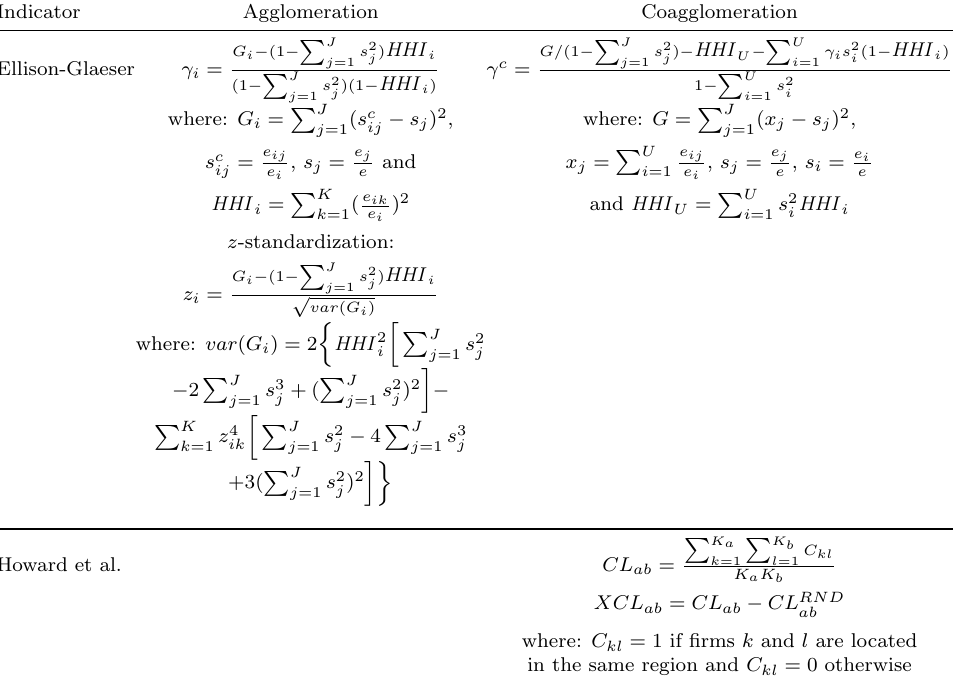
Table 6: Coefficients of agglomeration and coagglomeration using individual firm data Indicator Agglomeration Coagglomeration